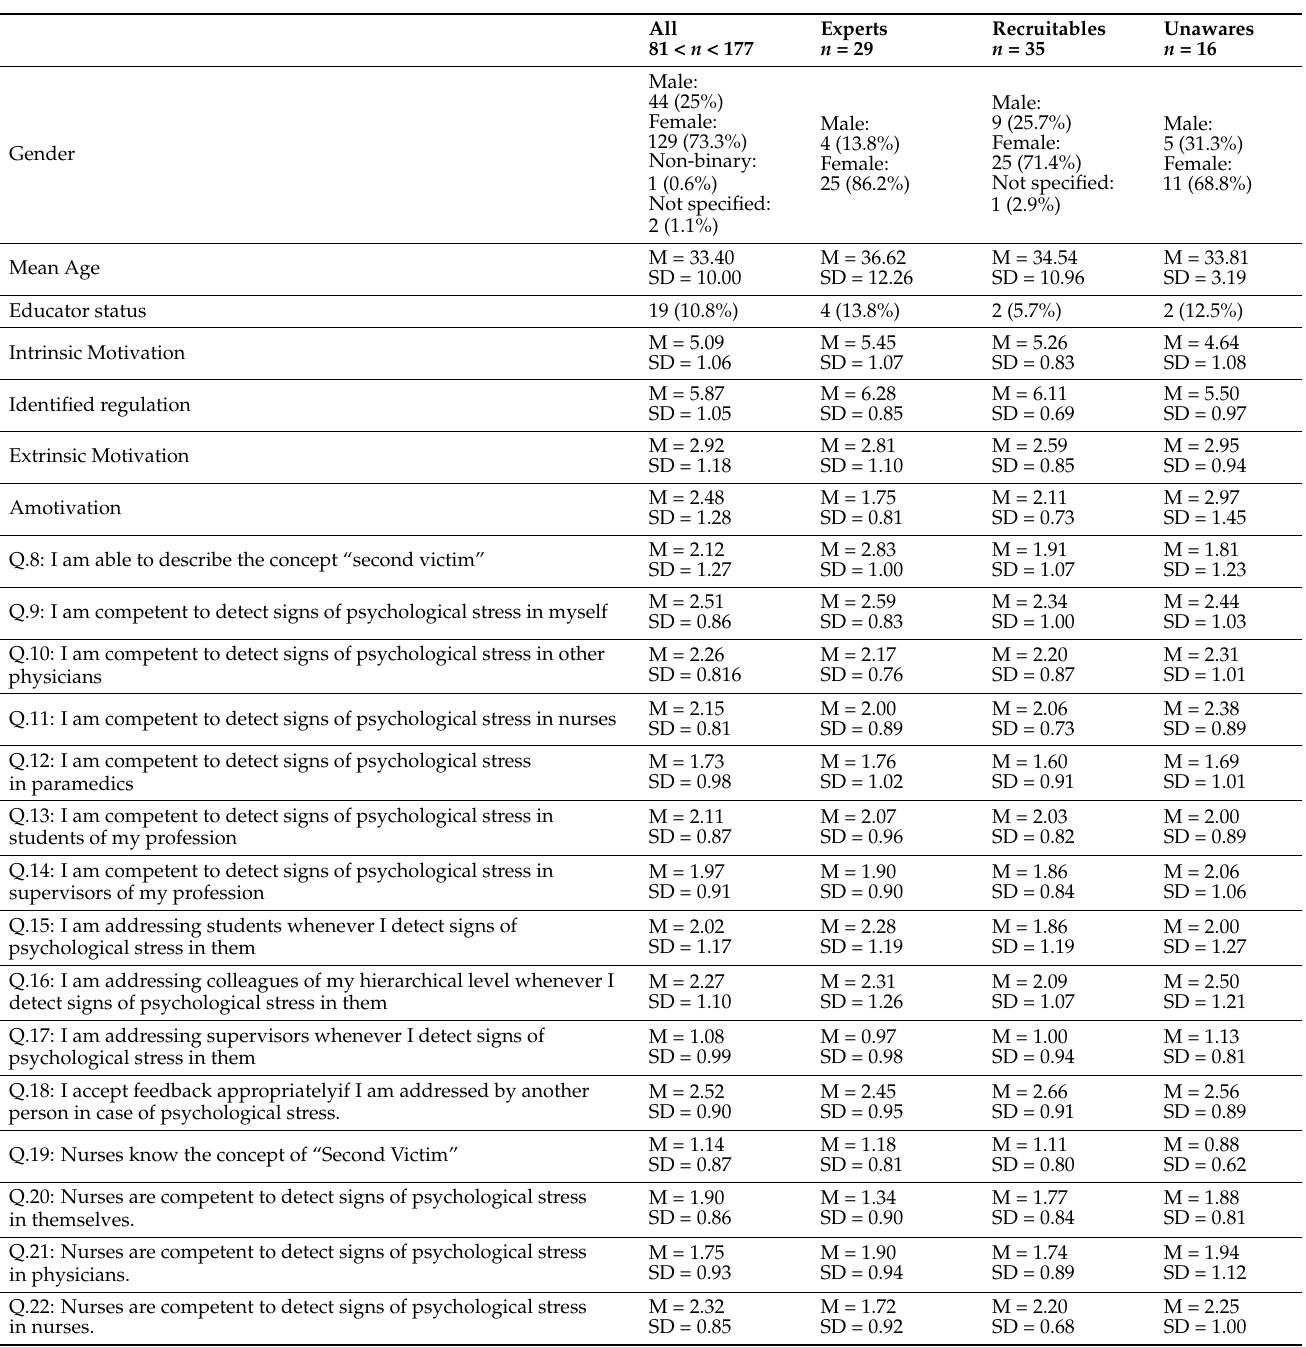
Table 1. Questionnaire and the results for all participants and the subgroups (M = mean, SD = standard deviation). Questions 8 to 51 used a 5-Point Likert Scale (“completely agree” = 4 to “completely disagree” = 0). Item 7 (the SIMS) used a 7-point Likert scale (“completely agree” = 7 to “completely disagree” =1). Other item scales are shown in the table. ALL are all participants who responded to the item, not necessarily completing the questionnaire, i.e., the participants who were not included in the cluster analysis due to non-response to all relevant items for the cluster analysis are included in ALL statistics. % of ALL is the proportion of all participants who responded to the item, and % of EXPERTS, RECRUITABLES and UNAWARES is the proportion of participants in the cluster. All 81 < n <